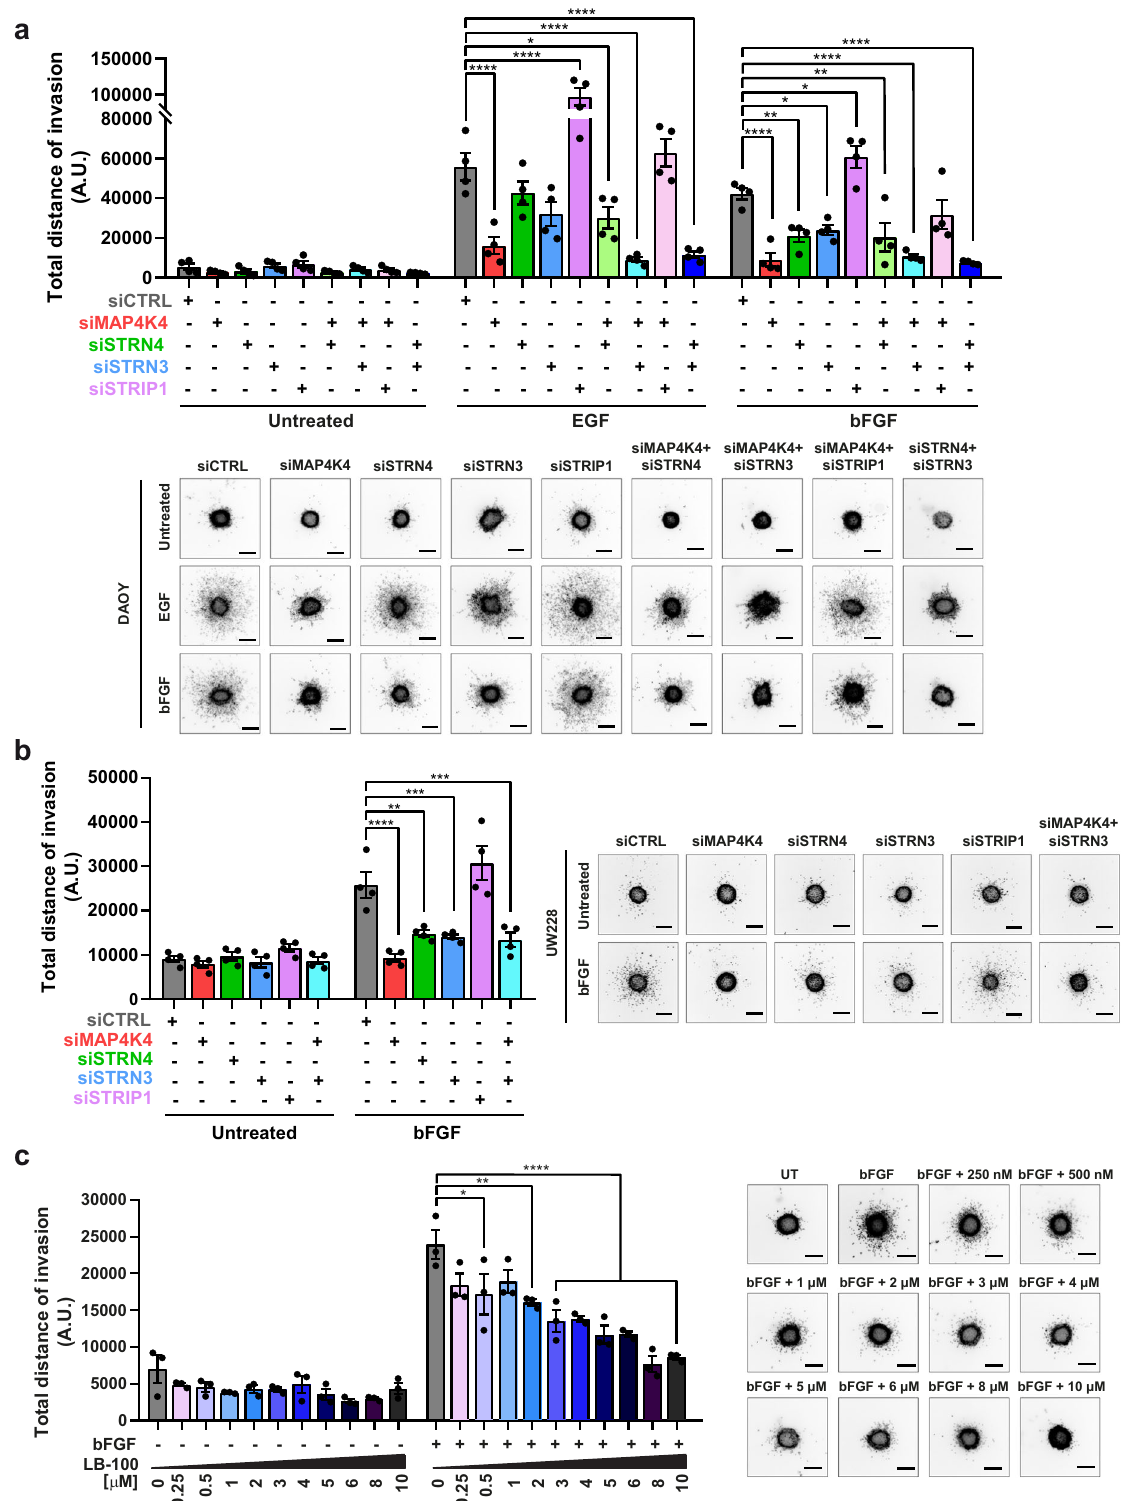
Fig. 2 STRIPAK complex disruption impairs GF-induced collagen I invasion. a Invasion and representative images of 3D spheroid invasion assay (SIA) of DAOY cells transfected with 10 nM of the indicated siRNA ± GFs (EGF: 30 ng/ml, bFGF: 100 ng/ml). Invasion is calculated as sum of the distances of each migrating cell from the center of the spheroids ( n = 4, means ± SEM). Scale bar: 300 µ m. b SIA of UW228 cells transfected with 10 nM of the indicated siRNA ± 100 ng/ml bFGF ( n = 4, means ± SEM). Scale bar: 300 µ m . c SIA and representative images of DAOY cells ± 100 ng/ml bFGF and ± increasing concentrations of PP2A inhibitor LB-100 ( n = 3, means ± SEM). * p < 0.05, ** p < 0.01, *** p < 0.001, **** p < 0.0001 (one-way ANOVA). Scale bar: 300 µ m. See also Fig. S3. Source data for quanti fi cations shown in (a-c) are available in Supplementary Data 6.